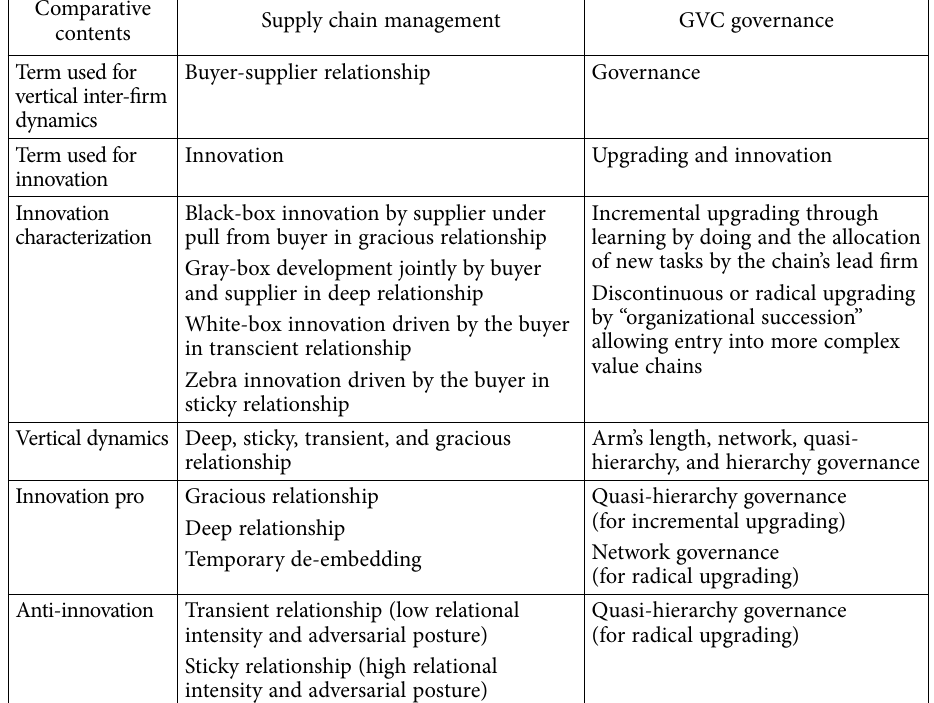
Table 1. Global buyer-supplier relationship and innovation (source: authors’ summary based on literatures) Comparative